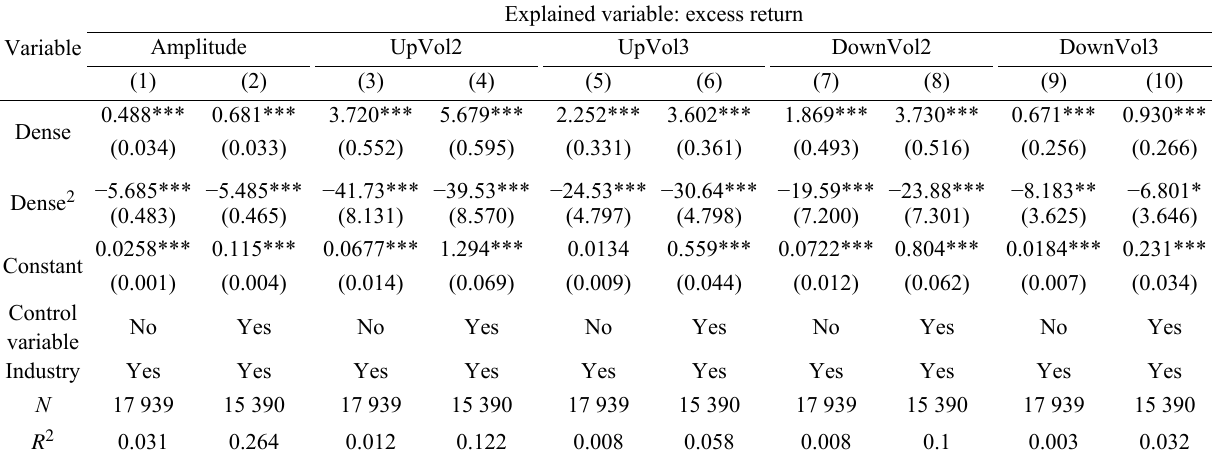
Table 13 Information diffusion speed and individual stocks